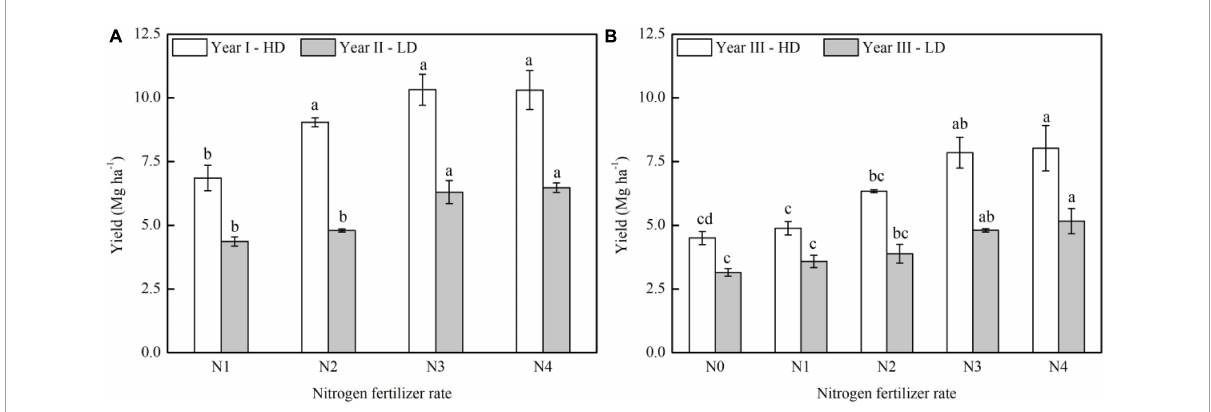
FIGURE2 Yield responses of bok choy to different chemical N fertilizer rates in Years I, II (A) , and Year III (B) . Treatments N0, N1, N2, N3, and N4 received 0, 45, 109, 157, and 205 kg · N · ha − 1 in the growth season, respectively. Different letters indicate significant differences among various N application rates in the specific year at the P < 0.05